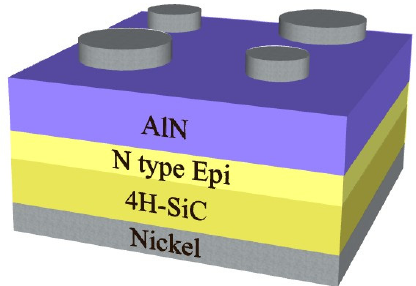
Figure 1. Structure of the fabricated AlN / 4H-SiC Schottky barrier diode samples.